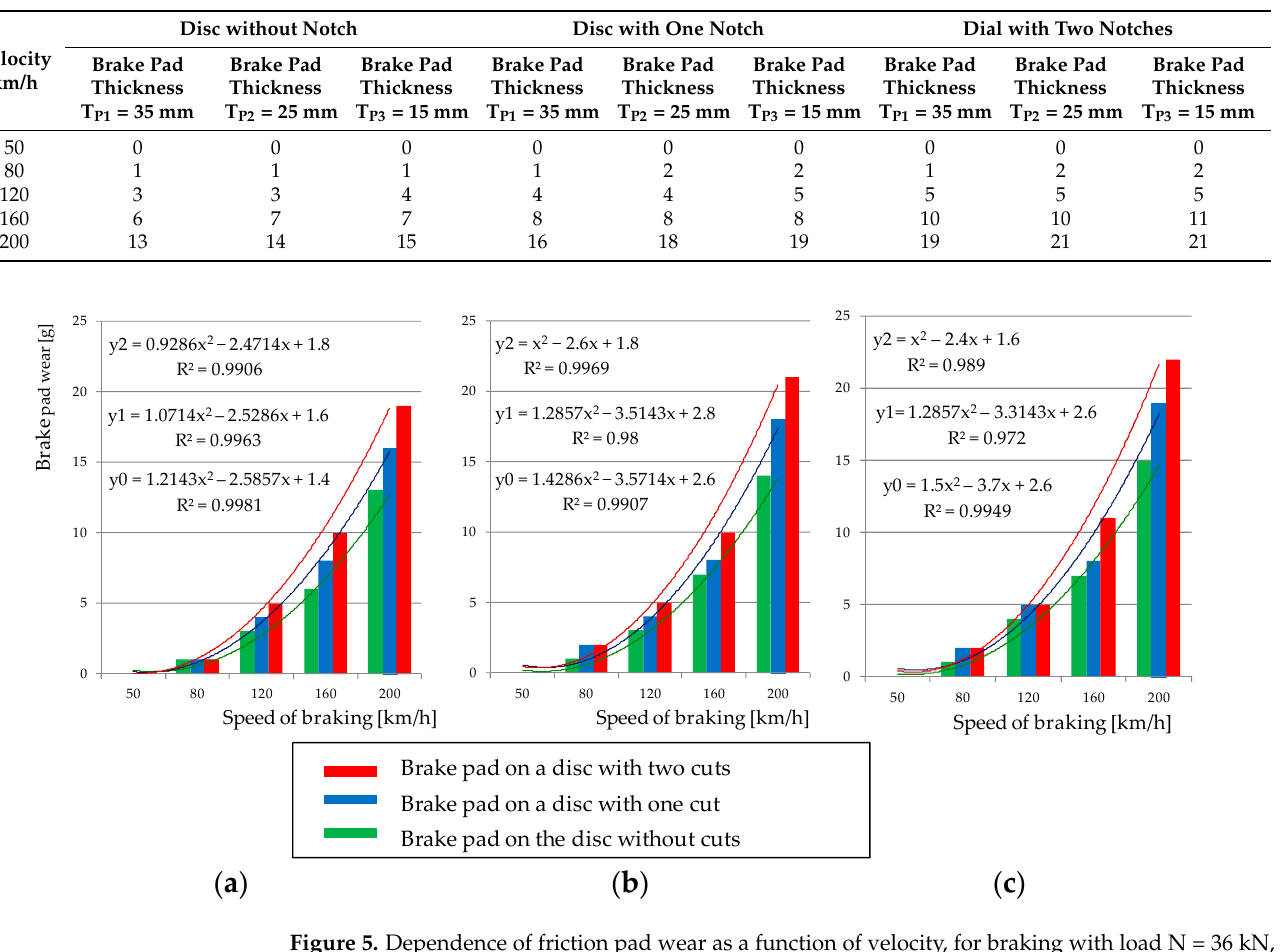
kN, braking mass M B = 6.7 t, braking on pads: ( a ) new, thickness 35 mm, ( b ) worn to the thickness of